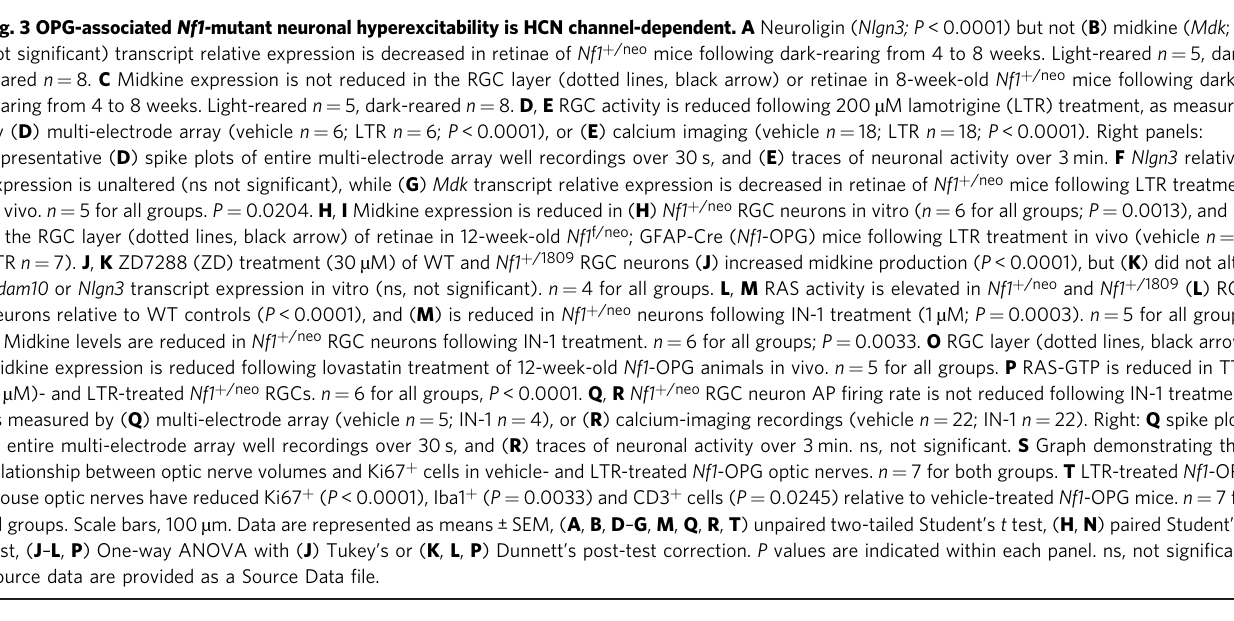
Fig. 3 OPG-associated Nf1- mutant neuronal hyperexcitability is HCN channel-dependent. A Neuroligin ( Nlgn3; P < 0.0001) but not ( B ) midkine ( Mdk ; ns not signi fi cant) transcript relative expression is decreased in retinae of Nf1 + /neo mice following dark-rearing from 4 to 8 weeks. Light-reared n = 5, dark- reared n = 8. C Midkine expression is not reduced in the RGC layer (dotted lines, black arrow) or retinae in 8-week-old Nf1 + /neo mice following dark- rearing from 4 to 8 weeks. Light-reared n = 5, dark-reared n = 8. D , E RGC activity is reduced following 200 µ M lamotrigine (LTR) treatment, as measured by ( D ) multi-electrode array (vehicle n = 6; LTR n = 6; P < 0.0001), or ( E ) calcium imaging (vehicle n = 18; LTR n = 18; P < 0.0001). Right